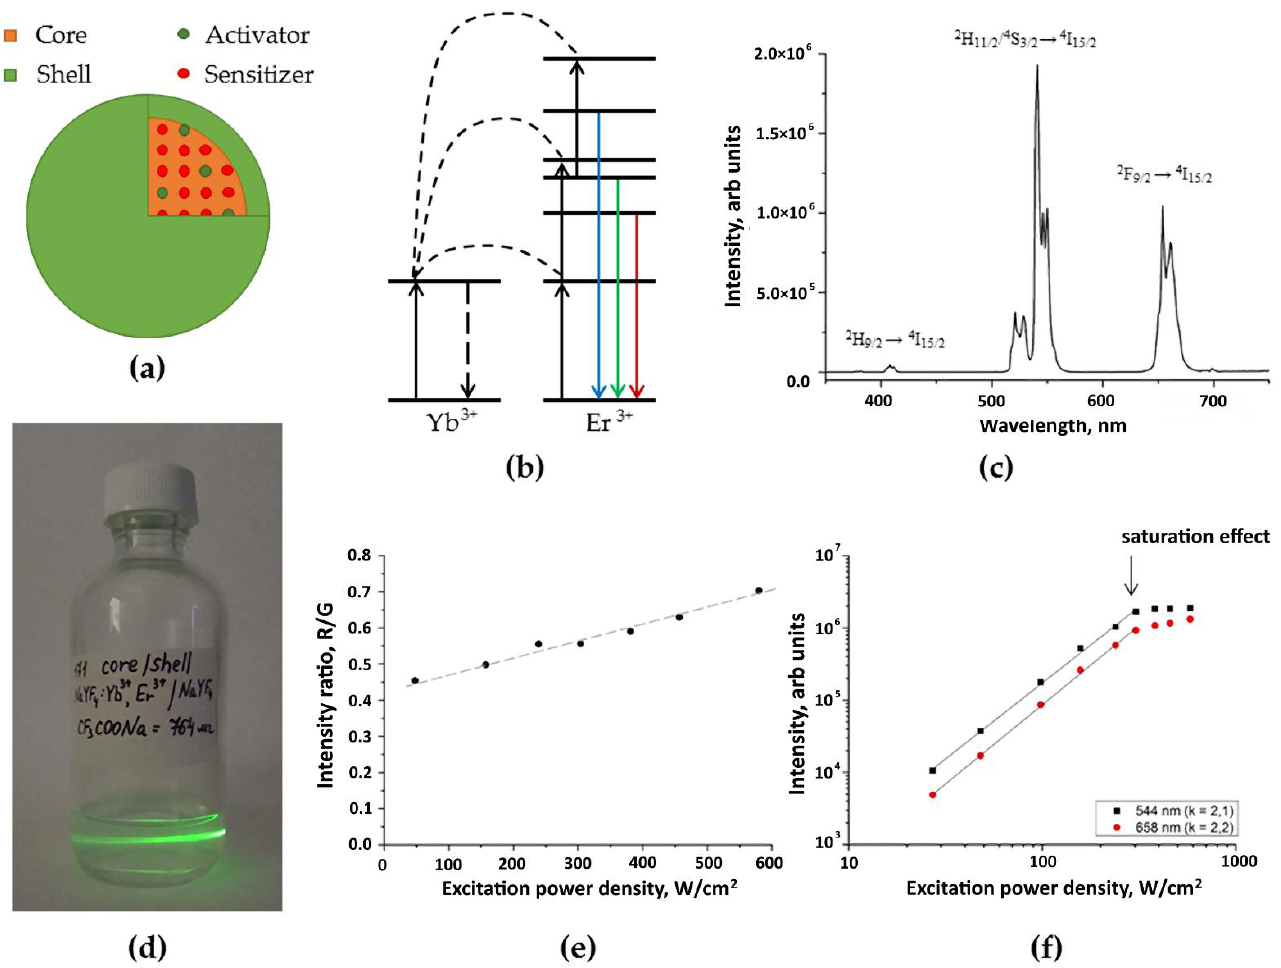
Figure 1. Characterization of upconversion core/shell β -NaYF 4 :Yb 3+ :Er 3+ /NaYF 4 nanoparticles: ( a ) schematic design of core/shell β -NaYF 4 :Yb 3+ :Er 3+ /NaYF 4 UCNPs; ( b ) energy level diagram of the UCNPs; ( c ) photoluminescence spectrum of the UCNPs; ( d ) photograph of the UCNPs under excitation at 976 nm; ( e ) dependence of the ratio of the intensity of the red luminescence band at a wavelength of 658 nm to that of the green one at a wavelength of 544 nm on the power density of exciting laser radiation for UCNPs; ( f ) dependences of the photoluminescence intensity on the power density of exciting radiation on a double logarithmic scale at wavelengths of 544 and 658 nm for the UCNPs.